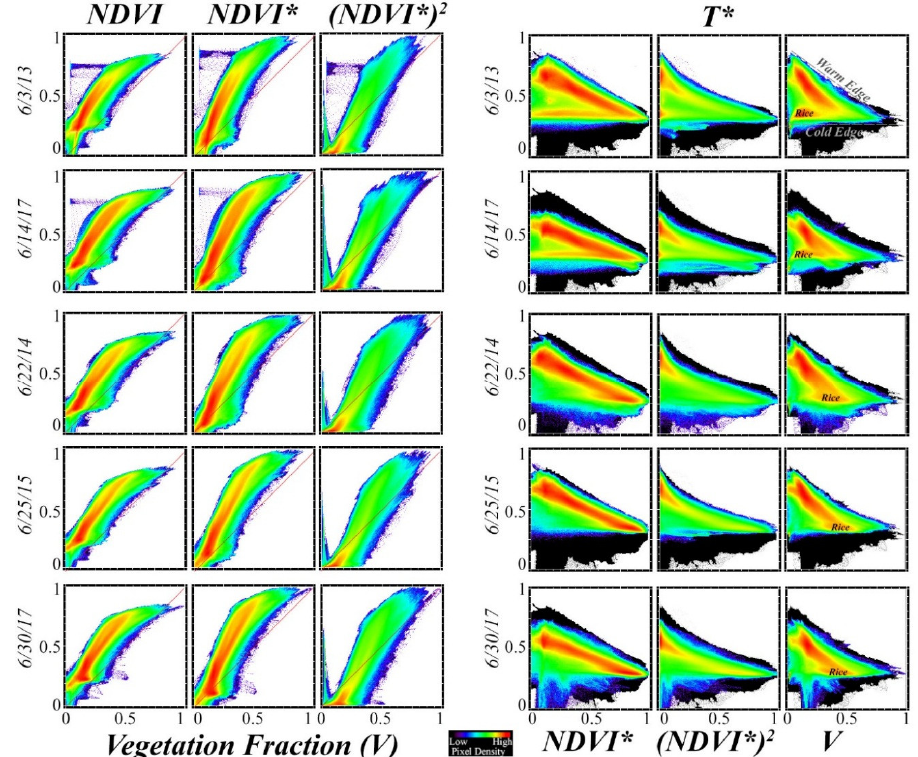
Figure 2. Vegetation metric comparison. L: Raw and transformed Normalized Difference Vegetation Index ( NDVI , y-axis) vs SMA-derived vegetation fraction ( V , x-axis). All three indices overestimate V at intermediate values and roll-off at high values. R: Bivariate distributions of vegetation